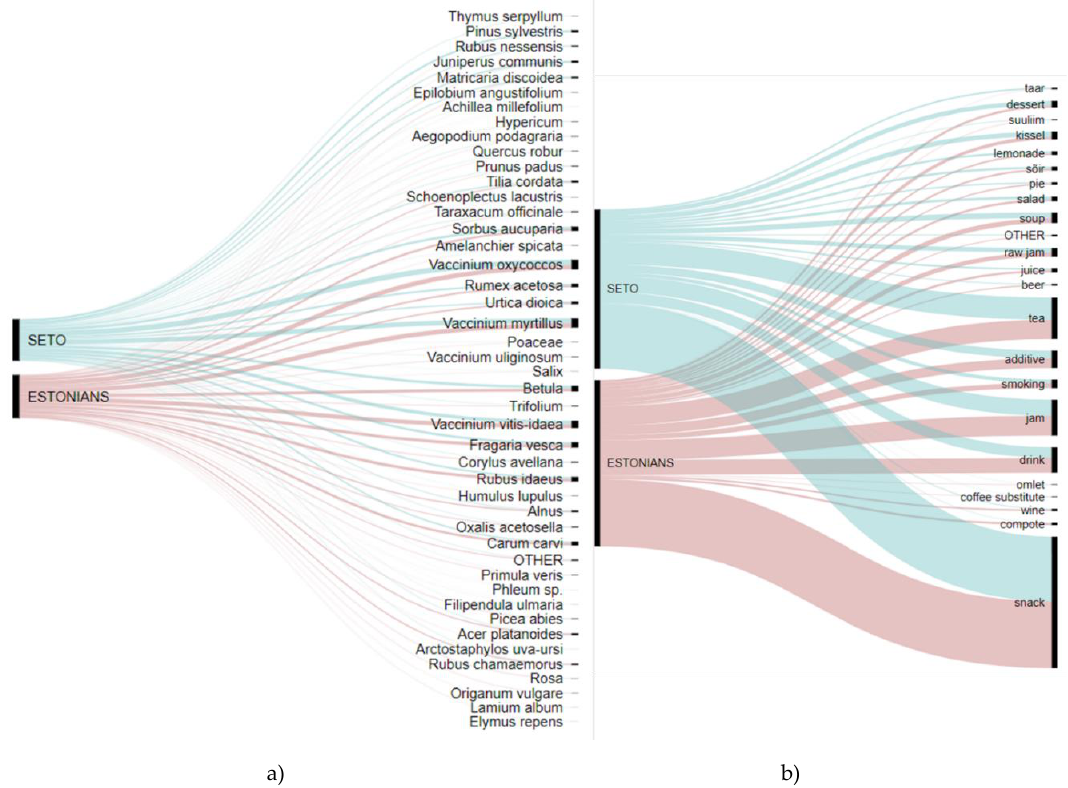
Figure 4. Alluvial diagrams representing the differences between the two groups for ( a ) taxa used and ( b ) food made.